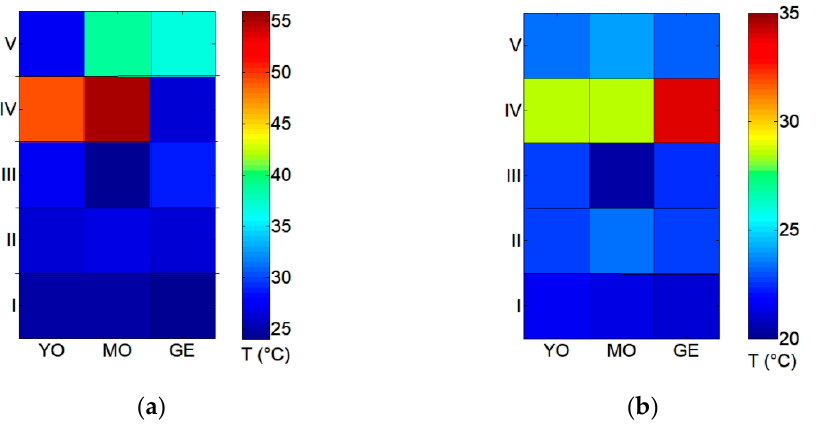
Figure 3. Plot of average temperatures measured with the infrared thermal camera as a function of laser treatment and pictorial layer of the irradiated 1 × 2 cm 2 zones ( a ) in dry and ( b ) wet condi-